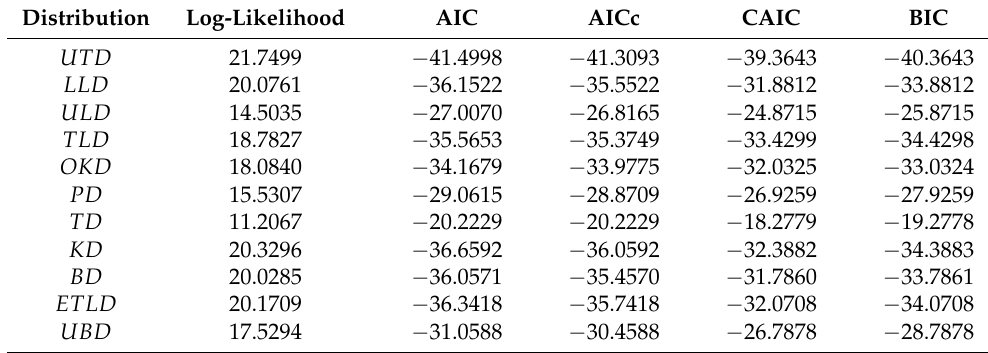
Table 12. Log-likelihood, AIC, AICc, CAIC, and BIC values for secondary reactor pumps data. Distribution